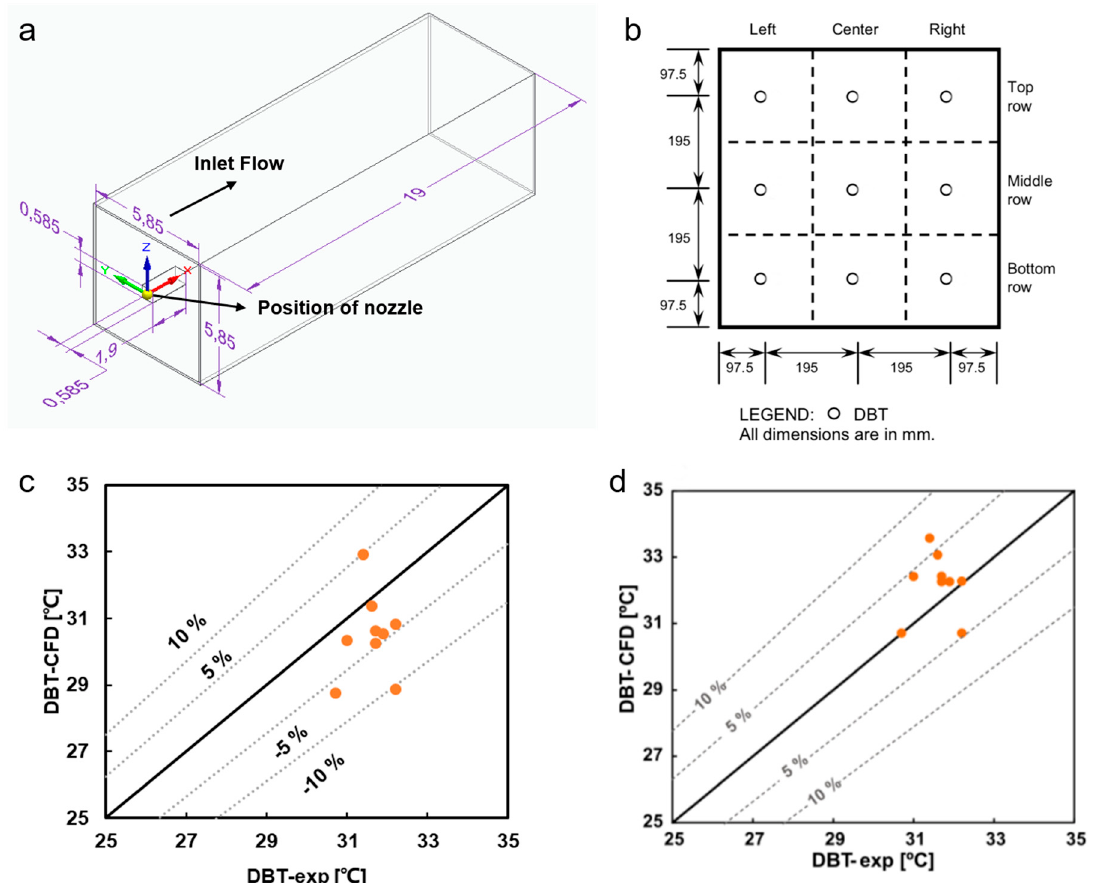
Figure 7. ( a ) The computational domain of the jet model from the present study. ( b ) The locations of dry-bulb temperature (DBT) measurement points on the outlet plane (modified from [48]). ( c ) DBTs comparison between current CFD results and previous experimental measurements [48]. ( d ) DBTs comparison between previous CFD results [49] and previous experimental measurements